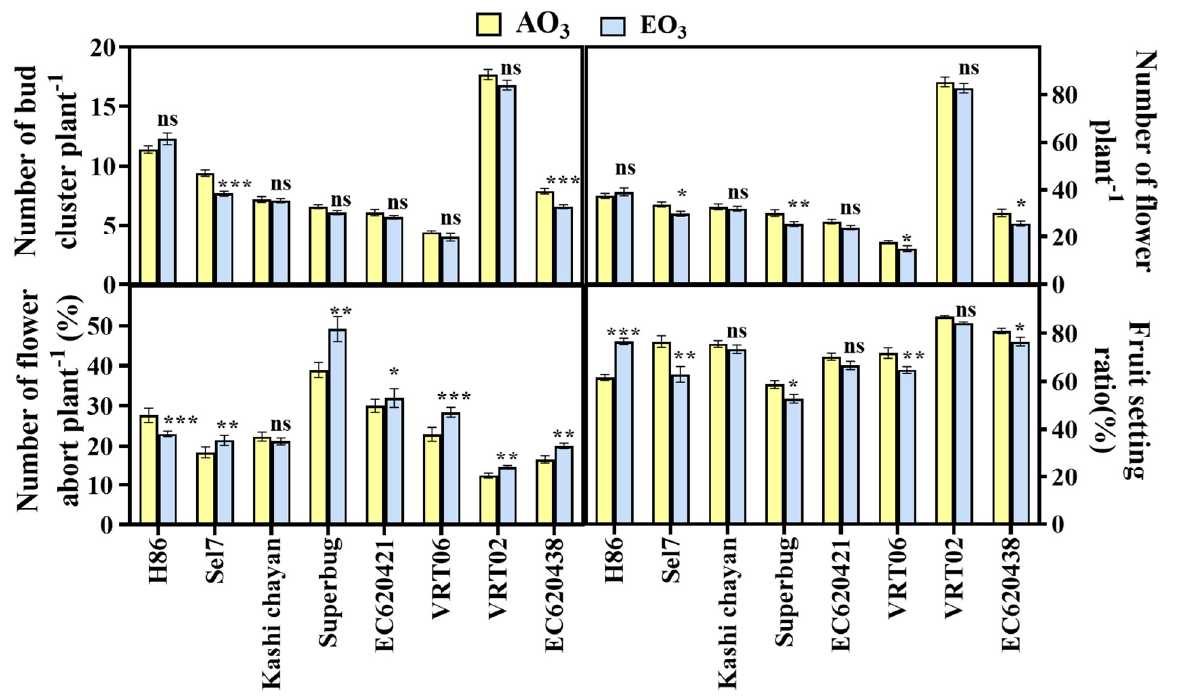
Figure 7. Variations in reproductive traits of tomato cultivars under ambient O 3 and elevated O 3 treatments. Values are mean ± SE. Levels of significance between AO 3 and EO 3 based on t -test: * p ≤ 0.05; ** p ≤ 0.01; *** p ≤ 0.001; ns not significant.